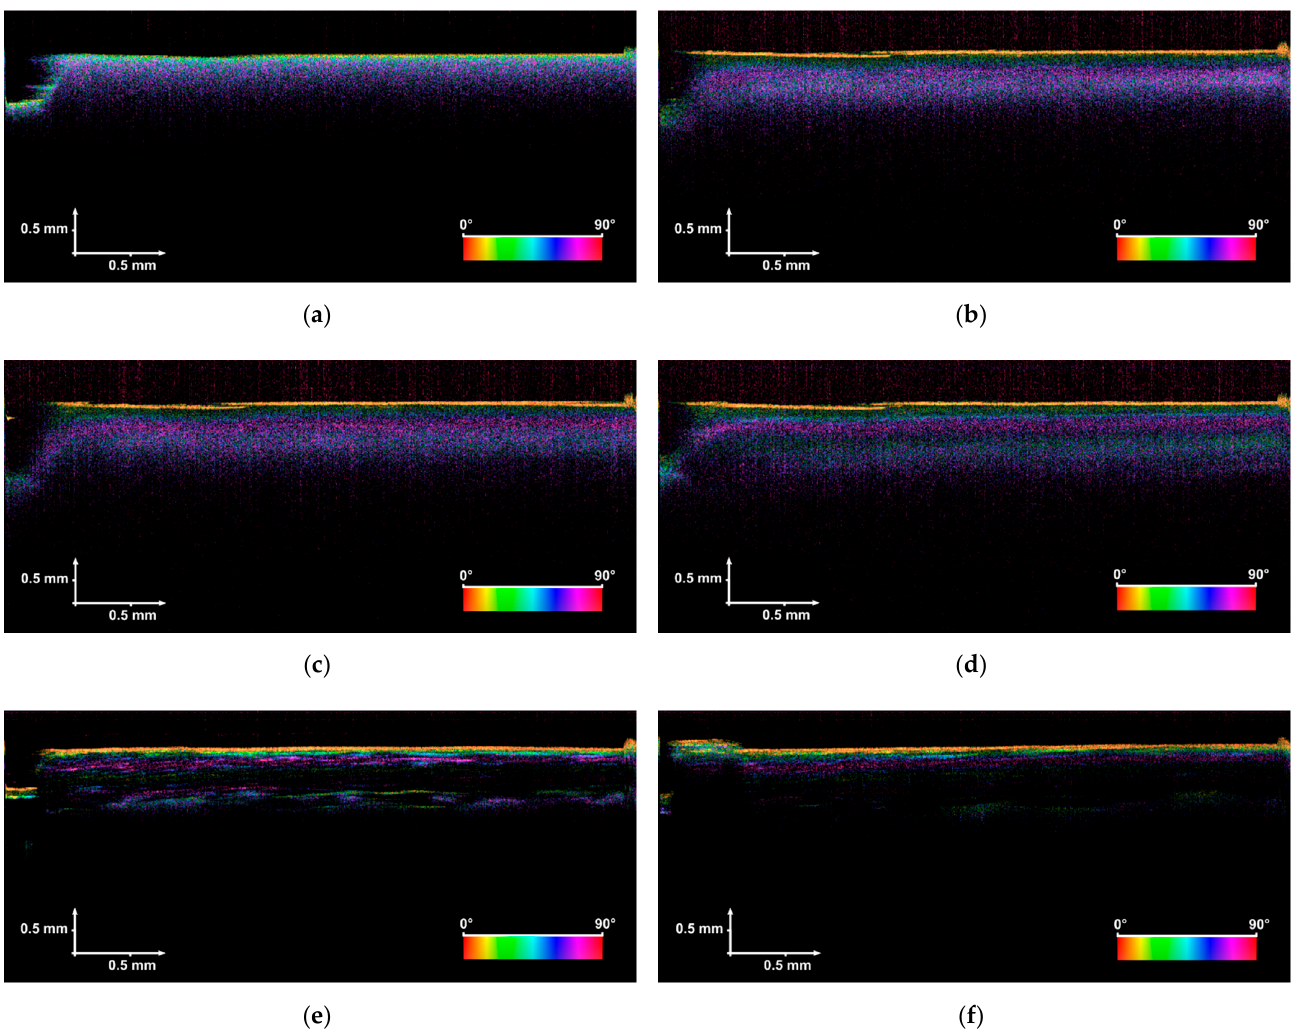
Figure 4. PS-OCT images of the tested bones taken in the first 24 h (sample B24h_OCT, figures ( a – d )) and 14 days (sample B14D_OCT, figures ( e , f )); ( a ) the image taken at the beginning of the experiment (the bone has not been exposed to the acetic acid), ( b ) after 1 h; ( c ) after 3 h; ( d ) after 24 h, ( e ) after 7 days, ( f ) after 14 days.